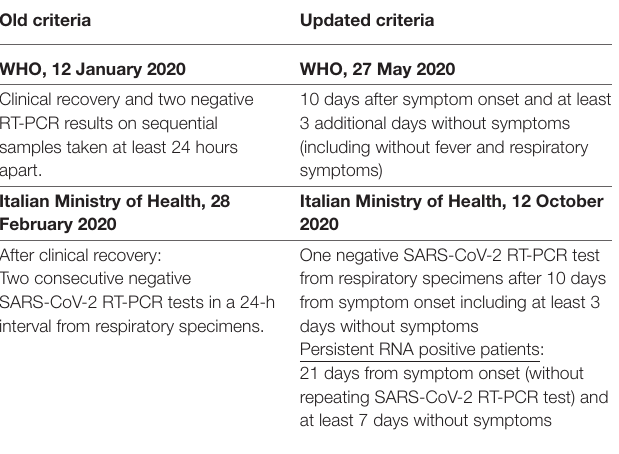
TABLE 1 | Criteria for releasing COVID-19 patients from